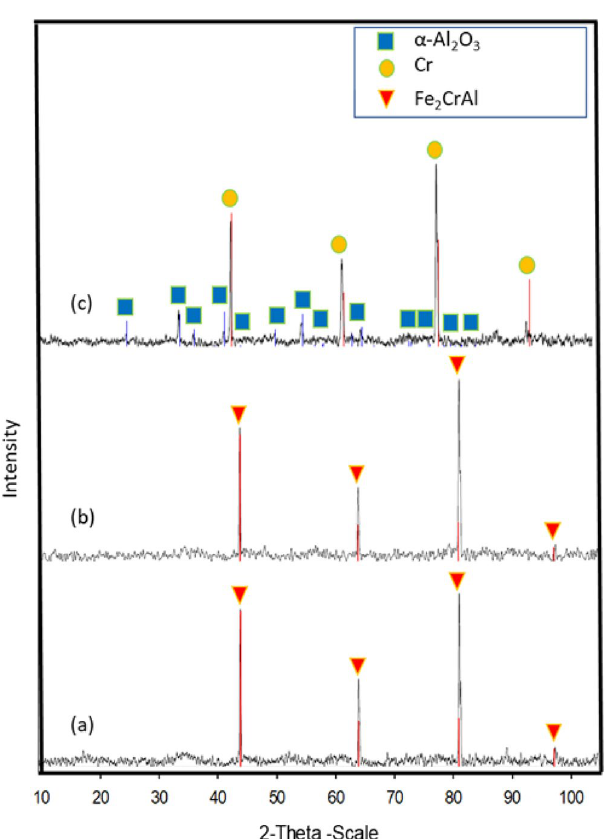
Figure 14. XRD test shows the crystalline pattern for ( a ) Sample 1, ( b ) Sample 2, and ( c ) Sample